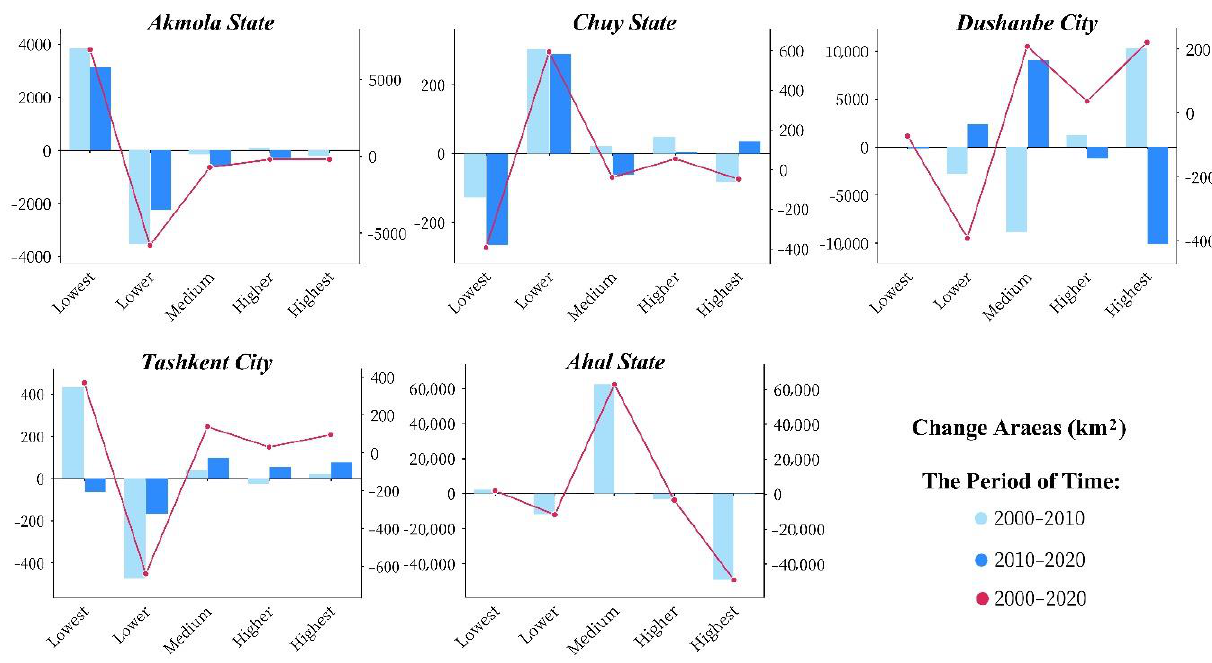
Figure 9. Changes of ecological risk area in different periods.